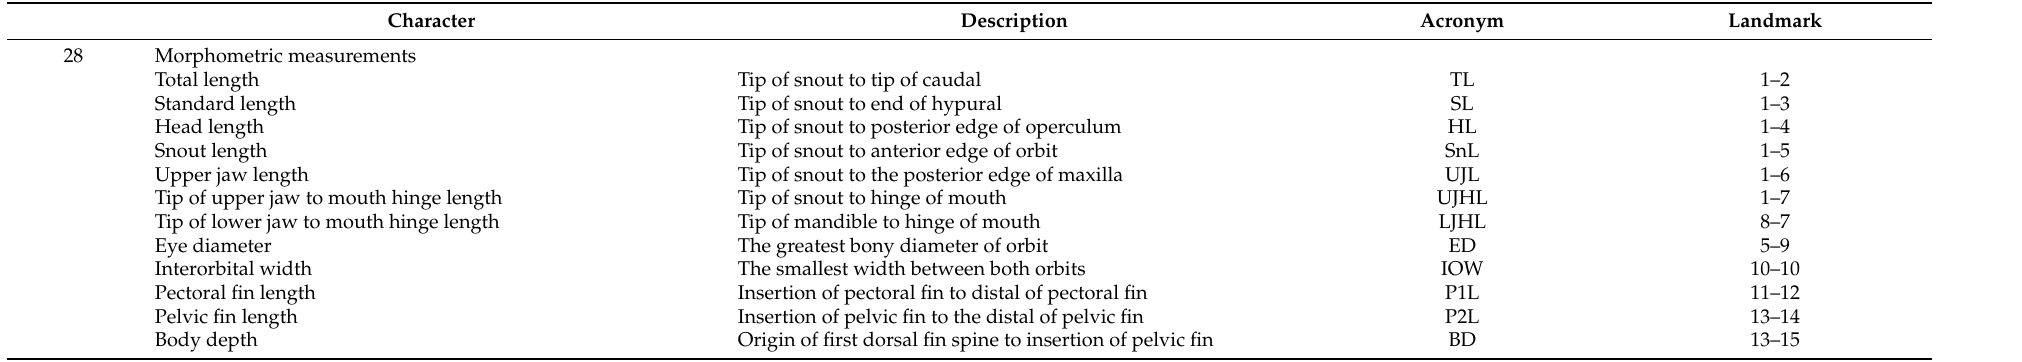
Figure 2. Schematic drawing of a sciaenid fish showing “landmarks” used for morphological measurements based on a truss network protocol, anchored at 29 homologous anatomical landmarks with the exception of gill raker length (see Table 1 for the specific definition of each measurement). Table 1. Definition of morphometric measurements and meristic counts for the genus Johnius